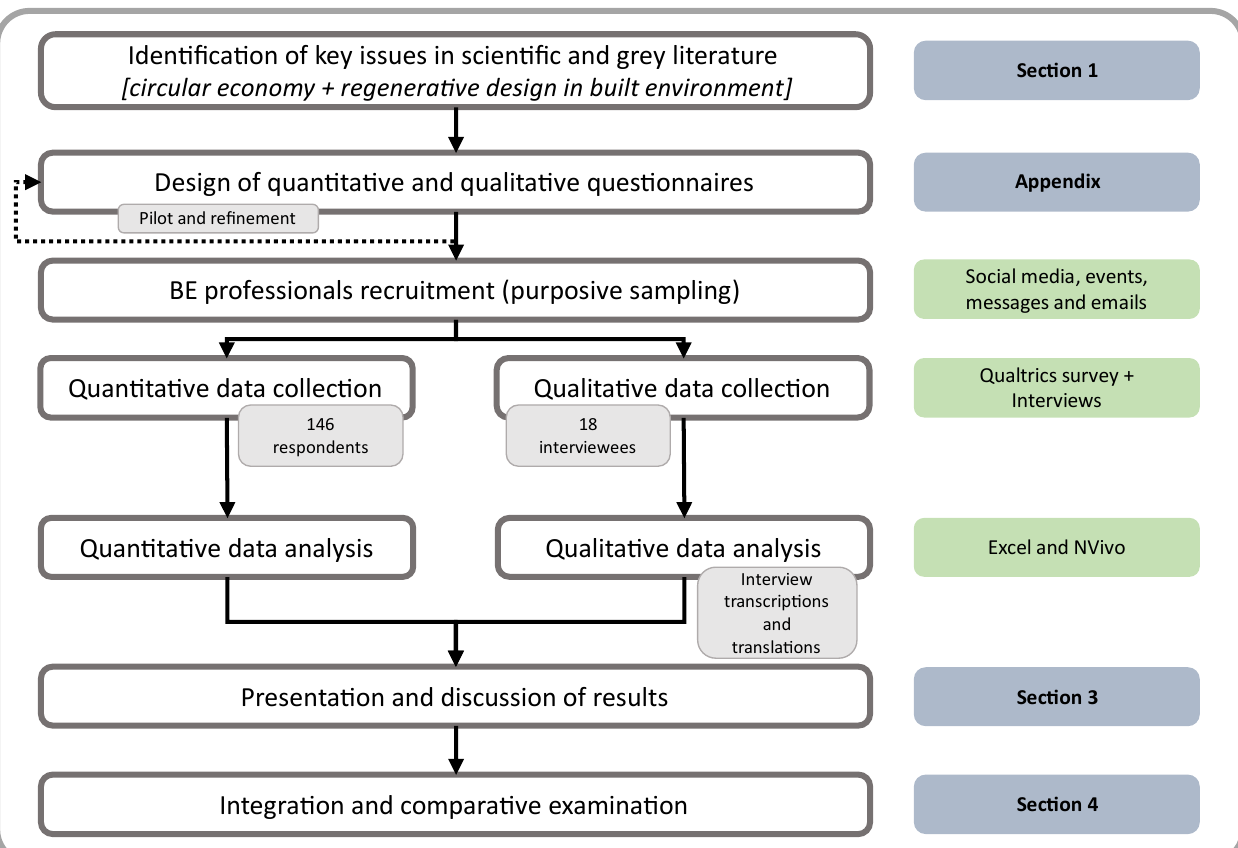
Figure 1. Research methodology schematics: convergent mixed methods design.